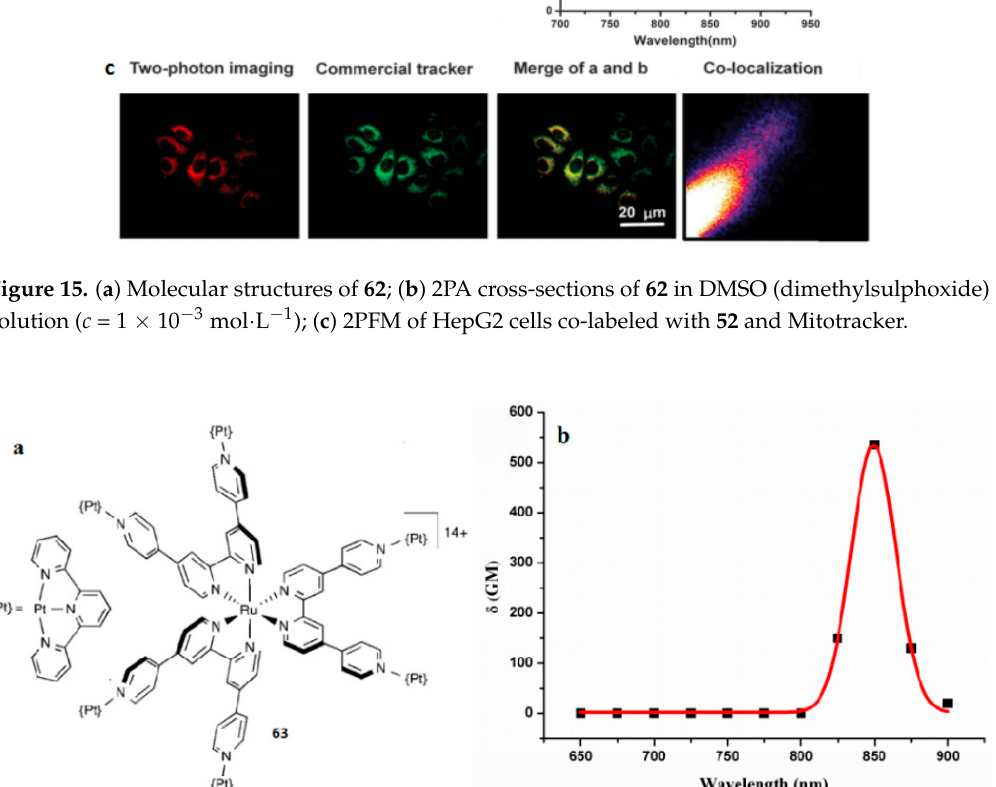
Figure 16. ( a ) Molecular structure of 63 ( b ) Dispersion of δ for 63 . The fit lines are of limited reliability due to the 25 nm separation between the data